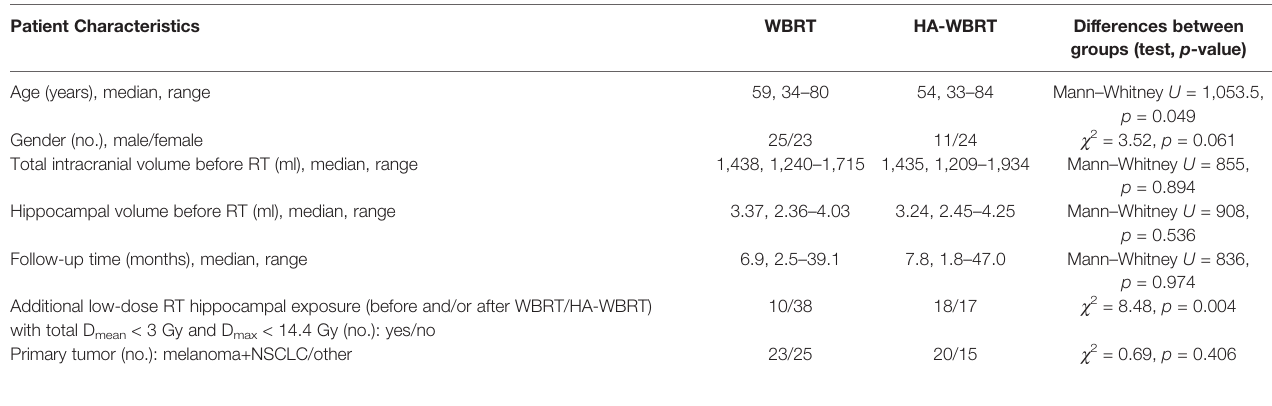
TABLE 1 | Clinical details of selected